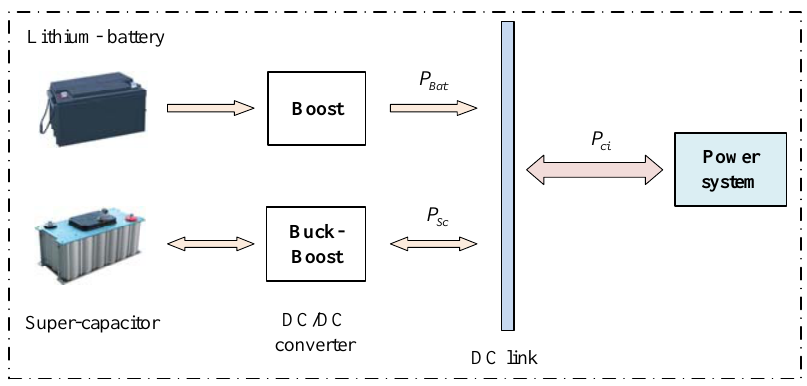
Figure 4. Power exchange between the HESS and power system.